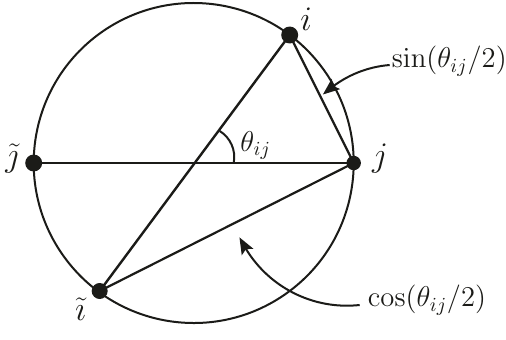
Figure 1 . Particle pairs on a